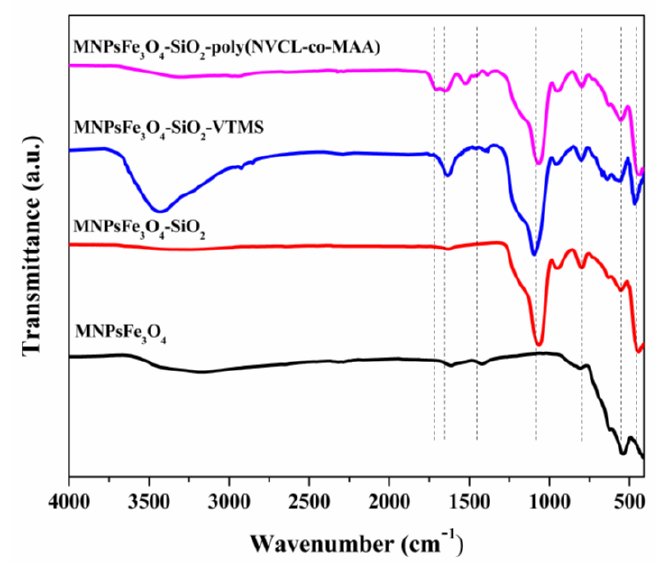
Figure 3. FTIR spectra of MNPsFe 3 O 4 -SiO 2 , MNPsFe 3 O 4 -SiO 2 -VTMS, and MNPsFe 3 O 4 -SiO 2 -poly (NVCL-co-MAA) nanocomposites.